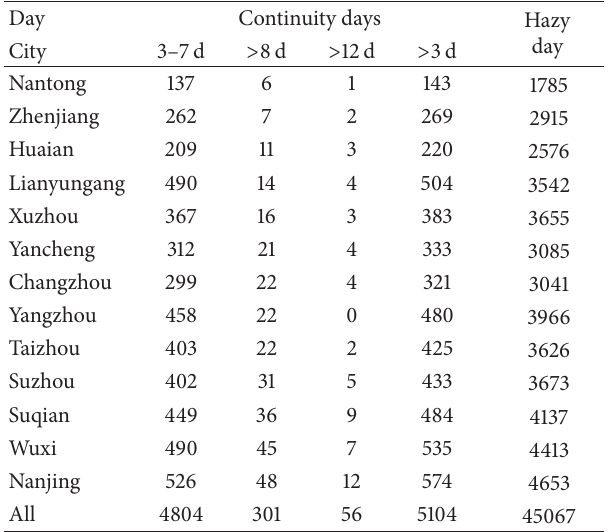
Table 2: Seasonal change of haze/d ⋅ year −1 . Table 3: Distribution of continuous hazy day